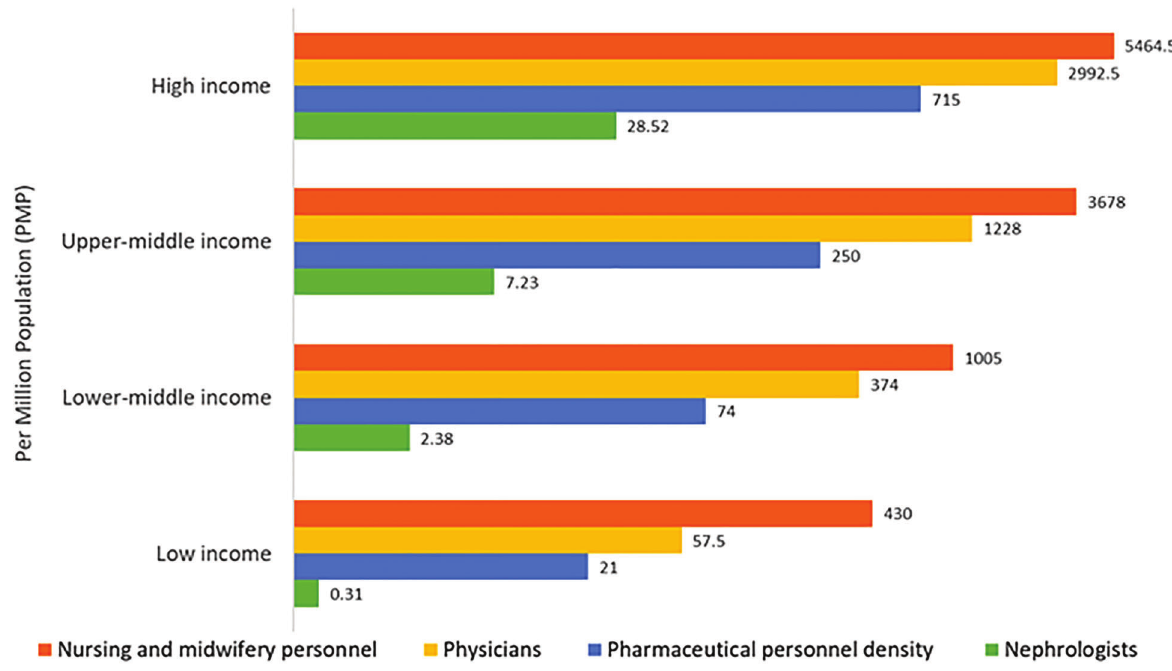
Figure 2. Nephrologist availability (density per million population) compared with physician, nursing, and pharmaceutical personnel availability by country income level. Pharmaceutical personnel include pharmacists, pharmaceutical assistants, and pharmaceutical technicians. Nursing and midwifery personnel include professional nurses, professional midwives, auxiliary nurses, auxiliary midwives, enrolled nurses, enrolled midwives, and related occupations such as dental nurses. A logarithmic scale was used for the x-axis [log(x + 1)] because of the large range in provider density. Data from Bello et al. (4), Osman et al. (43), and the World Health Organization (for pharmaceutical personnel: http://apps.who.int/gho/data/view.main.PHARMS and http://apps.who.int/gho/data/node.main-amro.HWF? lang=en, for nursing and midwifery personnel: http://apps.who.int/gho/data/view.main.NURSES, for physicians: http://apps.who.int/gho/ data/view.main.92000)